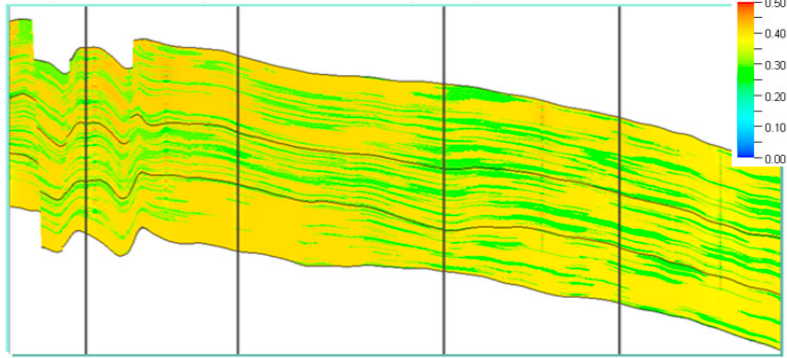
Figure 9. Cross-section map of Poisson ratio in the N–S direction.